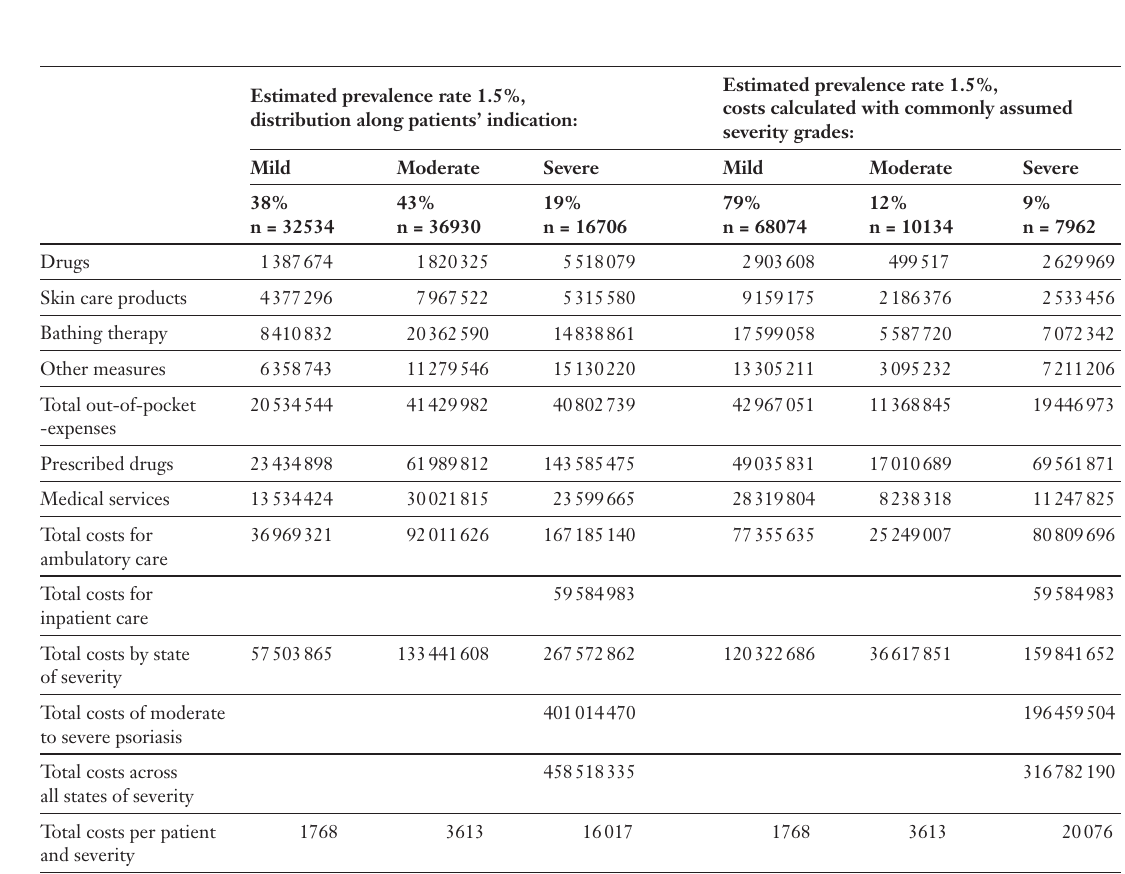
Costs of ambulatory care per patient per year according to state of severity.